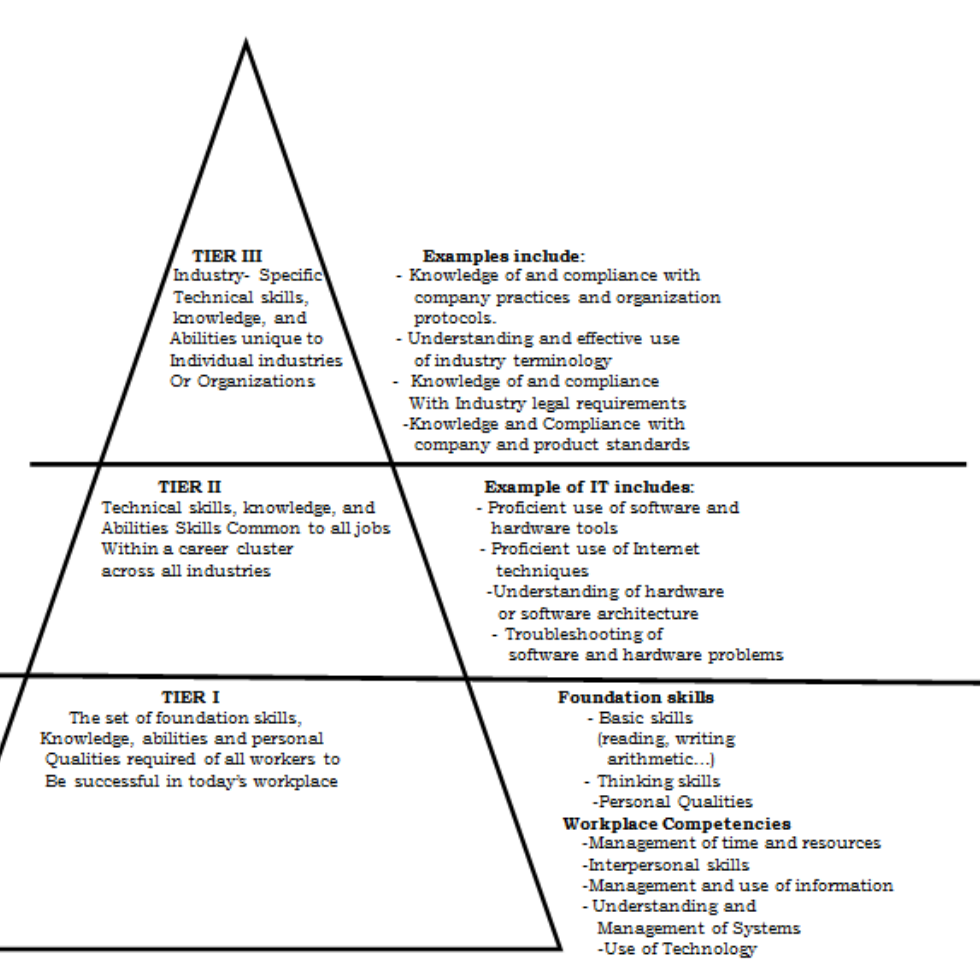
Figure 1. The IT Skills